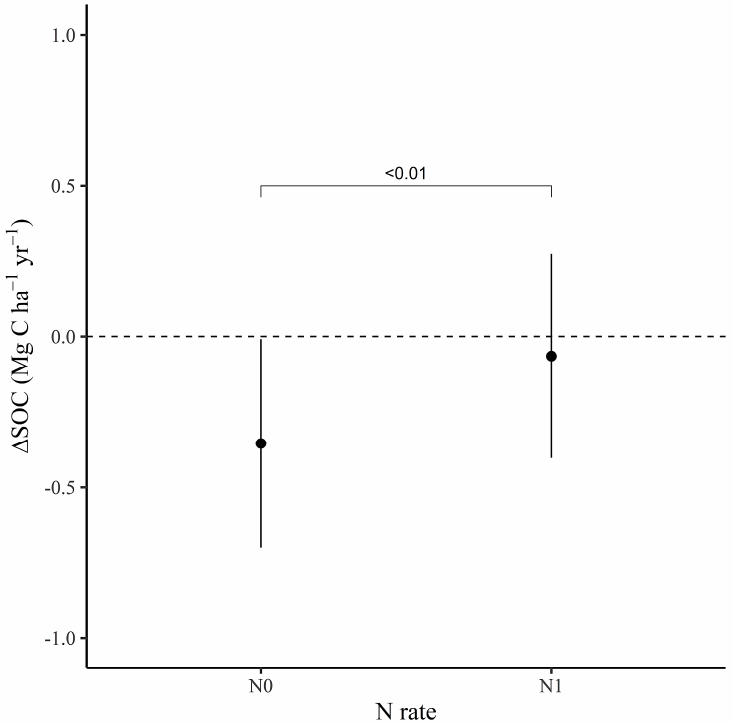
Figure 1. Mean annual SOC changes ( ∆ SOC) ( ± 95% confidence intervals) for the different N rates. N0: unfertilized, N1: fertilized using cattle slurry at a rate of 240 kg N ha − 1 in non-leguminous